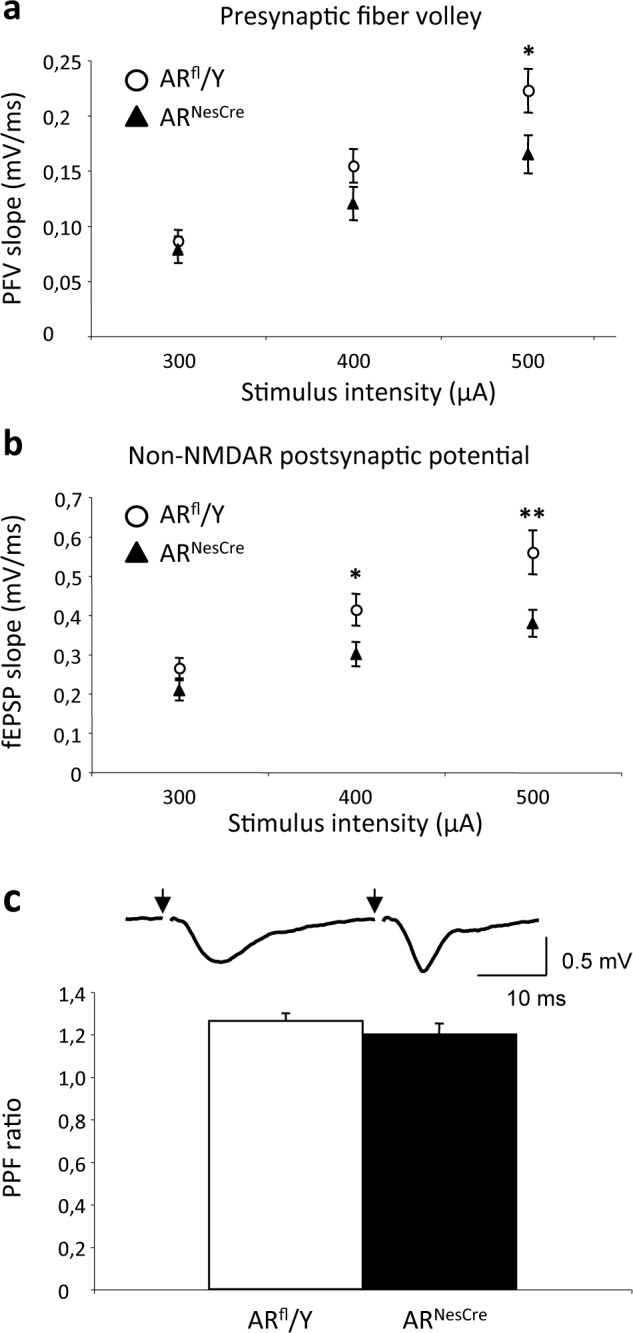
Basal synaptic transmission in the hippocampal CA1 area of ARfl/Y and ARNesCre male mice.(a-b) Input/output (I/O) curves of presynaptic fiber volleys (PFVs) (a) and field excitatory postsynaptic potentials (fEPSPs) (b) induced in control medium by the electrical stimulation of glutamatergic afferents (44 slices from 8 males per genotype). PFV magnitude was significantly smaller in ARNesCre males only at the highest stimulus intensity (*p < 0.05), whereas fEPSP values were already lower at lower intensities (**p < 0.01). (c) Upper panel, representative paired-pulse facilitation (PPF) of fEPSPs induced in a ARNesCre male by two successive stimuli (arrows) delivered with a 30 ms inter-stimulus interval. Lower panel, mean PPF magnitude (28–29 slices per genotype).